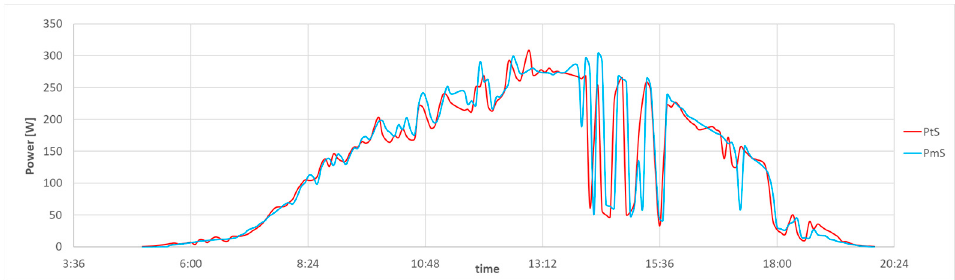
Figure A2. Comparison of simulated and measured power waveforms for PV cells oriented southward, bearing 200°; PtE—theoretical power, PmE—measured power.